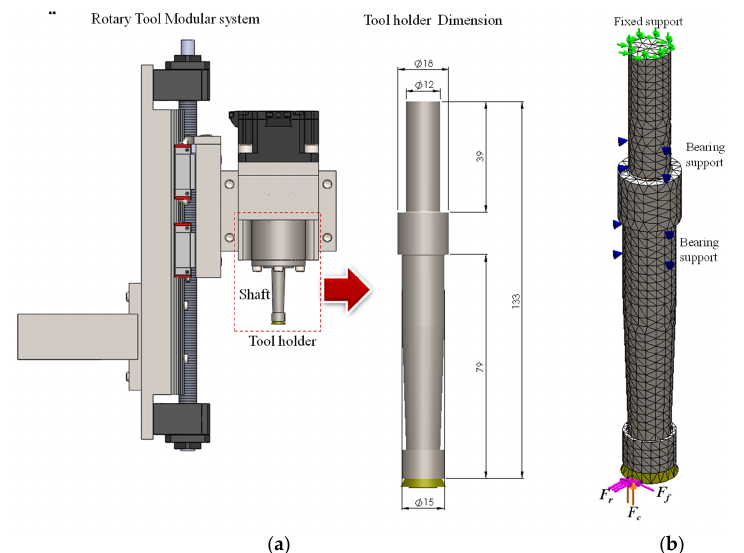
Figure 1. FEA model of the rotary tool holder: ( a ) rotary tool holder and its dimensions; ( b ) boundary condition for FEA simulation of deflection and natural frequency.